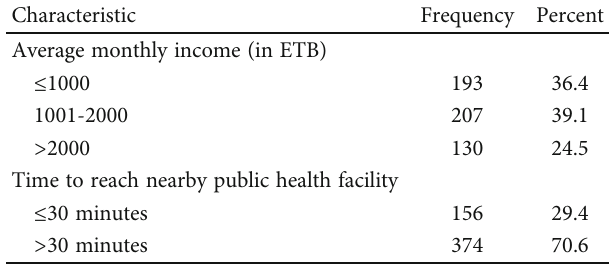
Table 1: Sociodemographic characteristics of women gave birth in public health facilities in East Hararghe Zone, eastern